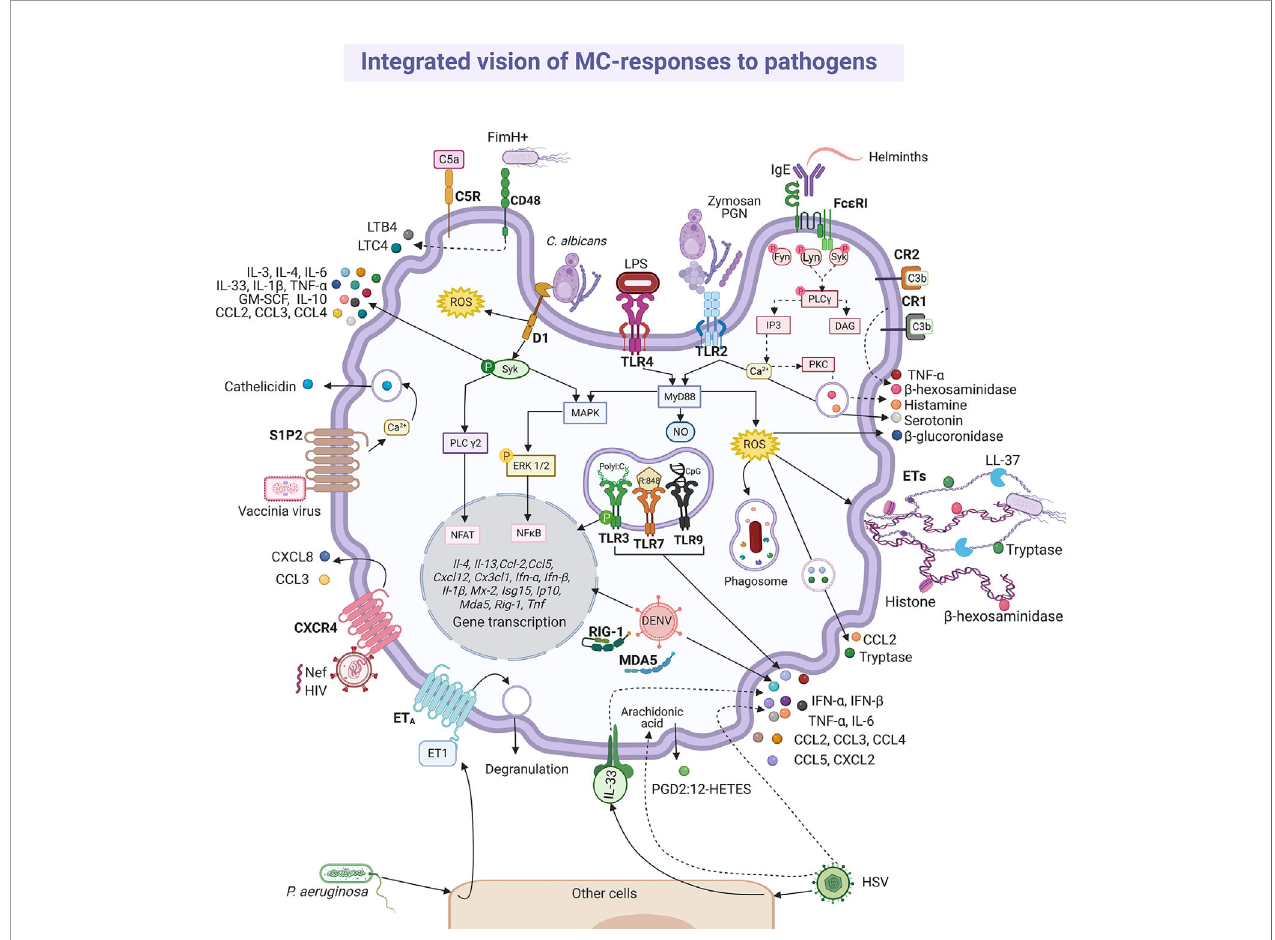
FIGURE 9 | Integrated responses of MCs to distinct pathogens. Distinct pattern recognition receptors (PRRs) expressed in MCs directly recognize pathogens, promoting phagocytosis, extracellular traps (ETs) formation and the release of pre-formed and de novo synthesized mediators. Canonical signaling pathways described for PRRs have increased complexity in MCs, where PRR triggering leads not only to the activation of NF k B but also to the secretion of granule content by anaphylactic and piecemeal degranulation. MC activation is observed also as a secondary event after the production of mediators by other cells, which causes the ampli fi cation of the initial in fl ammatory response. On the other hand, IgE-mediated Fc ϵ RI signaling cascade by parasites leads to a protective anaphylactic degranulation response that appears to require the activation of well-described signaling pathways participating in the allergic response. Finally, bacterial phagocytosis, ET release and secretion of mediators seem to be connected by mechanisms to be de fi ned yet. Solid-lines indicate known signaling pathways, whereas dashed-lines indicate suggested pathways or reported effects triggered by receptor stimulation or interactions of MCs with pathogens. LPS, lipopolysaccharide; PGN,